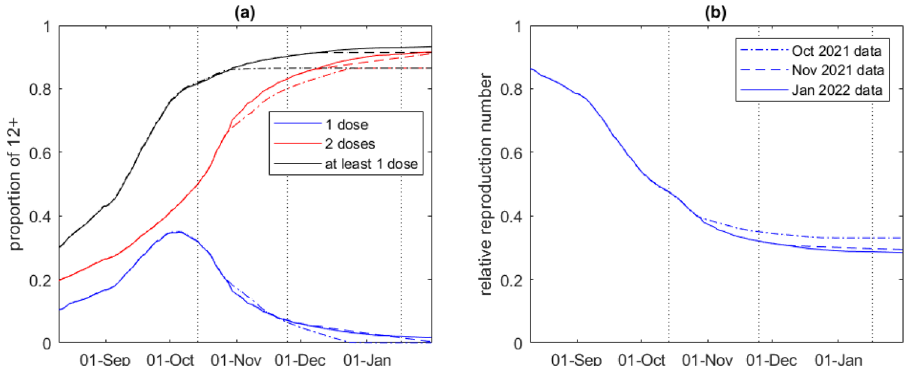
Figure 1. ( a ) Proportion of the Auckland population over 12 years old that had received 1 dose (blue), at least 1 dose (black), and 2 doses (red) over time. ( b ) Estimated effect of vaccination on the reproduction number over time. Vaccine coverage is calculated based on a combination of data on vaccines administered to date, data on future vaccination bookings, and projected future uptake of second doses (see Vaccine effectiveness and coverage section of Methods for details). Results are shown based on data accessed on three different dates (indicated by vertical dotted lines): 14 October 2021 (dash-dot), 25 November 2021 (dashed) and 17 January 2022